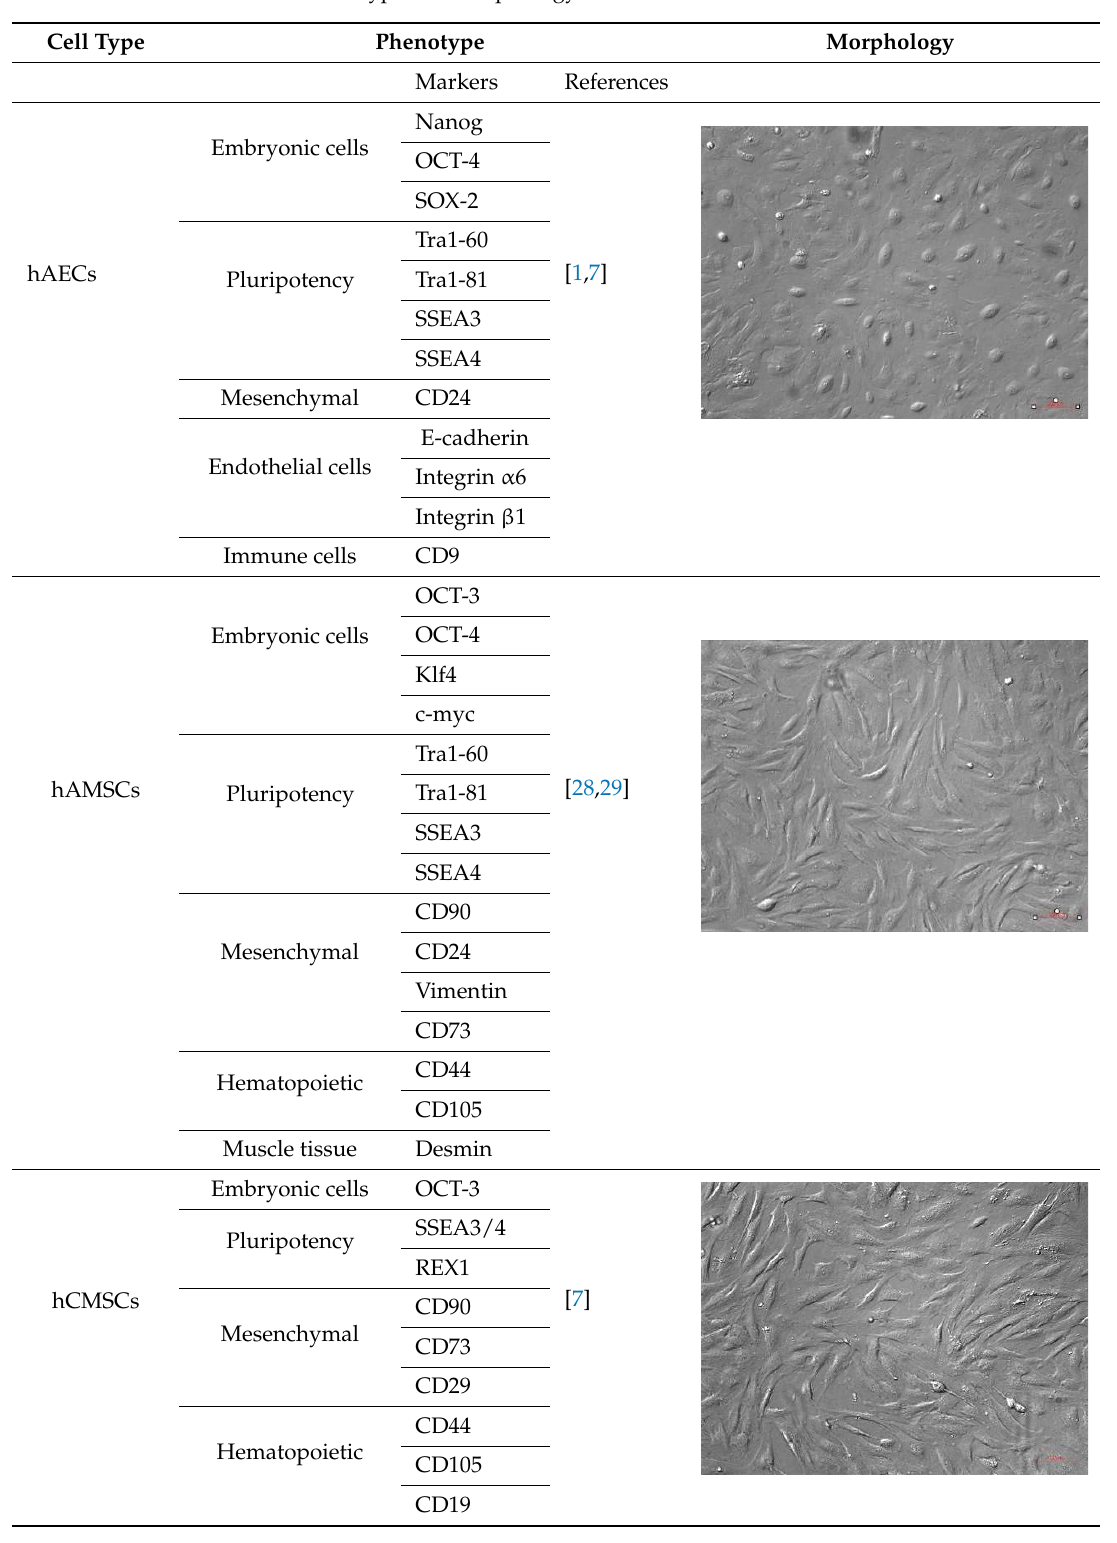
Table 1. Phenotype and morphology of stem cells from fetal annexes.